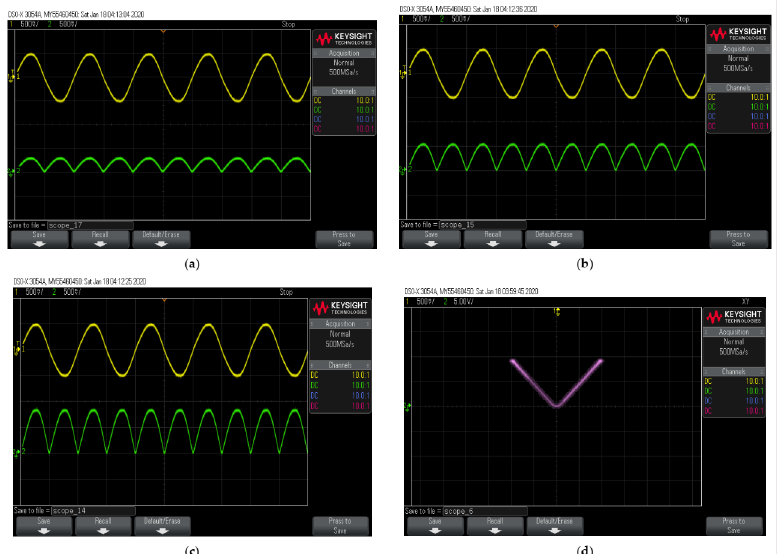
Figure 17. Experimental result obtained using commercial ICs ( a ) At bias current 50 µ A ( b ) At bias current 100 µ A ( c ) At bias current 200 µ A ( d ) DC transfer characteristic.